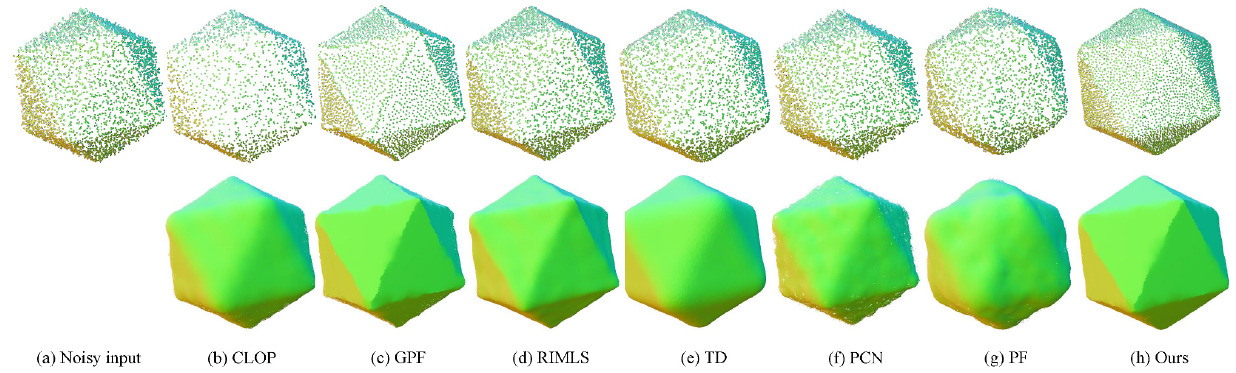
Fig. 6 Above: results on Icosahedron corrupted with 1.0% synthetic noise. Below: corresponding upsampling results.